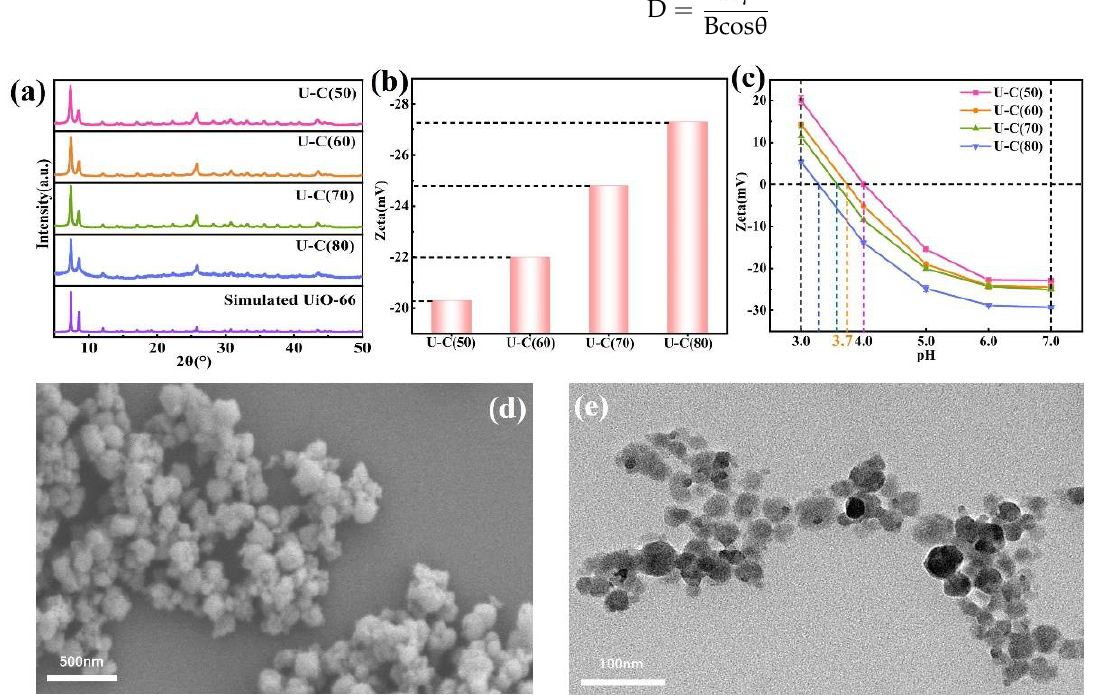
Figure 1. ( a ) XRD patterns of four different carboxyl groups of UiO-66-(COOH) 2 nanoparticles and simulated UiO-66. ( b ) Zeta potential of four different carboxyl groups of UiO-66-(COOH) 2 nanoparticles. ( c ) Zeta potential of UiO-66-(COOH) 2 with different H 4 BTEC contents as a function of pH. ( d ) SEM and ( e ) TEM images of the U-C(50) nanoparticles.